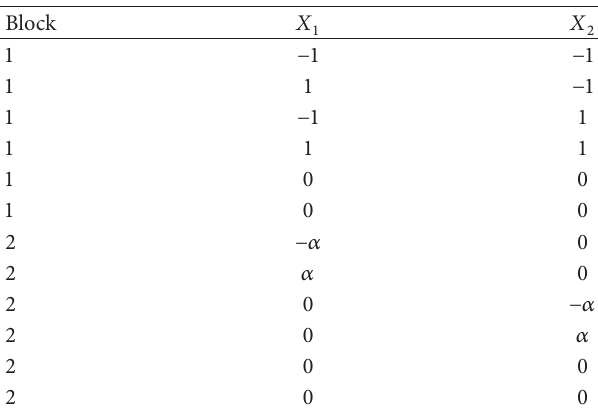
Table 3: CCD design with 3 center points for the tensile strength test.